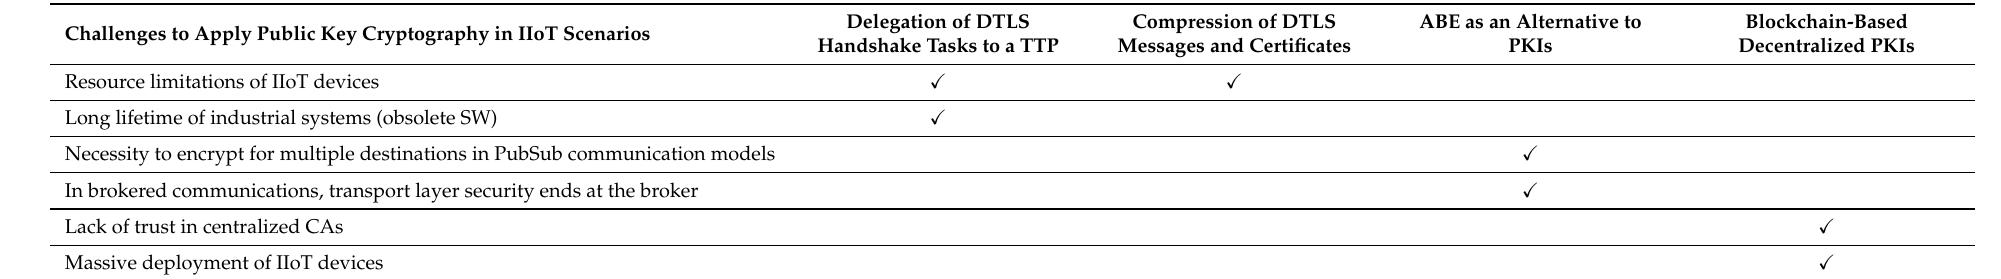
Table 6. Issues of public key cryptography in IIoT scenarios addressed by the different proposed